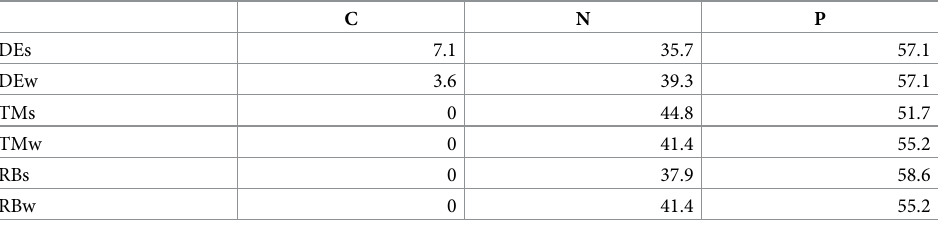
Table 2. Percentage of nodes limited by carbon (C), nitrogen (N) and phosphorus (P). DE: Durban Eddy, TM: Thukela Mouth, RB: Richard Bay, s: summer, w: